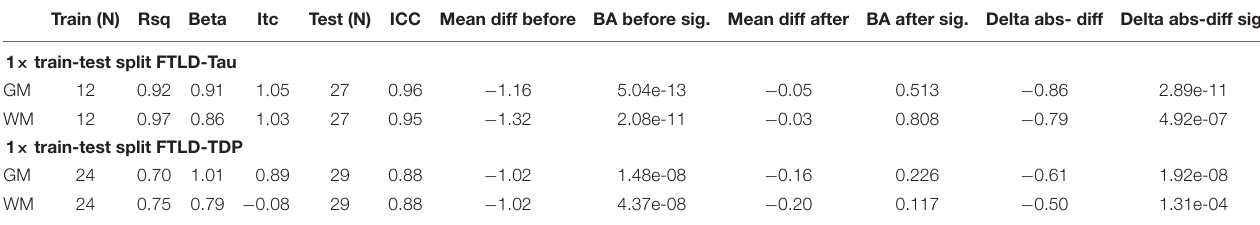
TABLE 4 | Application of transformation method in a single train-test split to determine reduction in batch-related difference in measurements (Step 3). Train (N) Rsq Beta